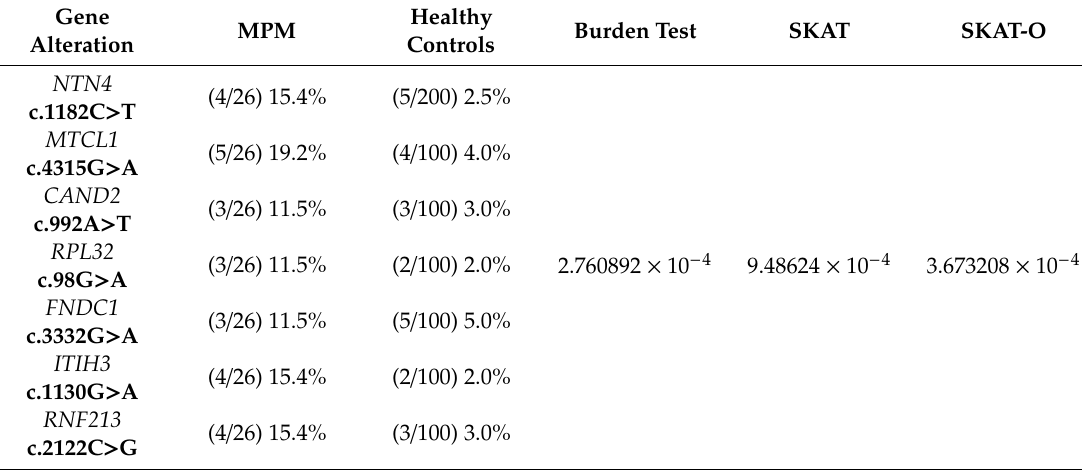
Table 2. Region-based aggregation tests for multiple variants. Region-based aggregation tests were performed to determine the cumulative e ff ects of the multiple polymorphic variants identified in this study, namely, the burden test, the sequence kernel association test (SKAT) and the SKAT-O test.